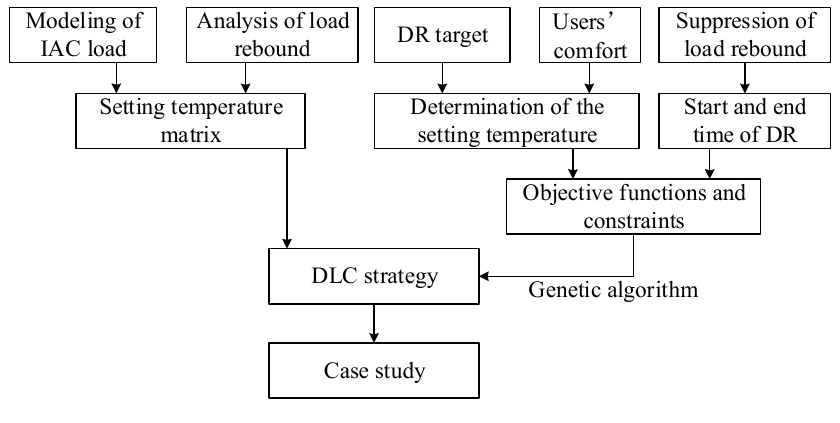
Figure 1. The structure of the paper.